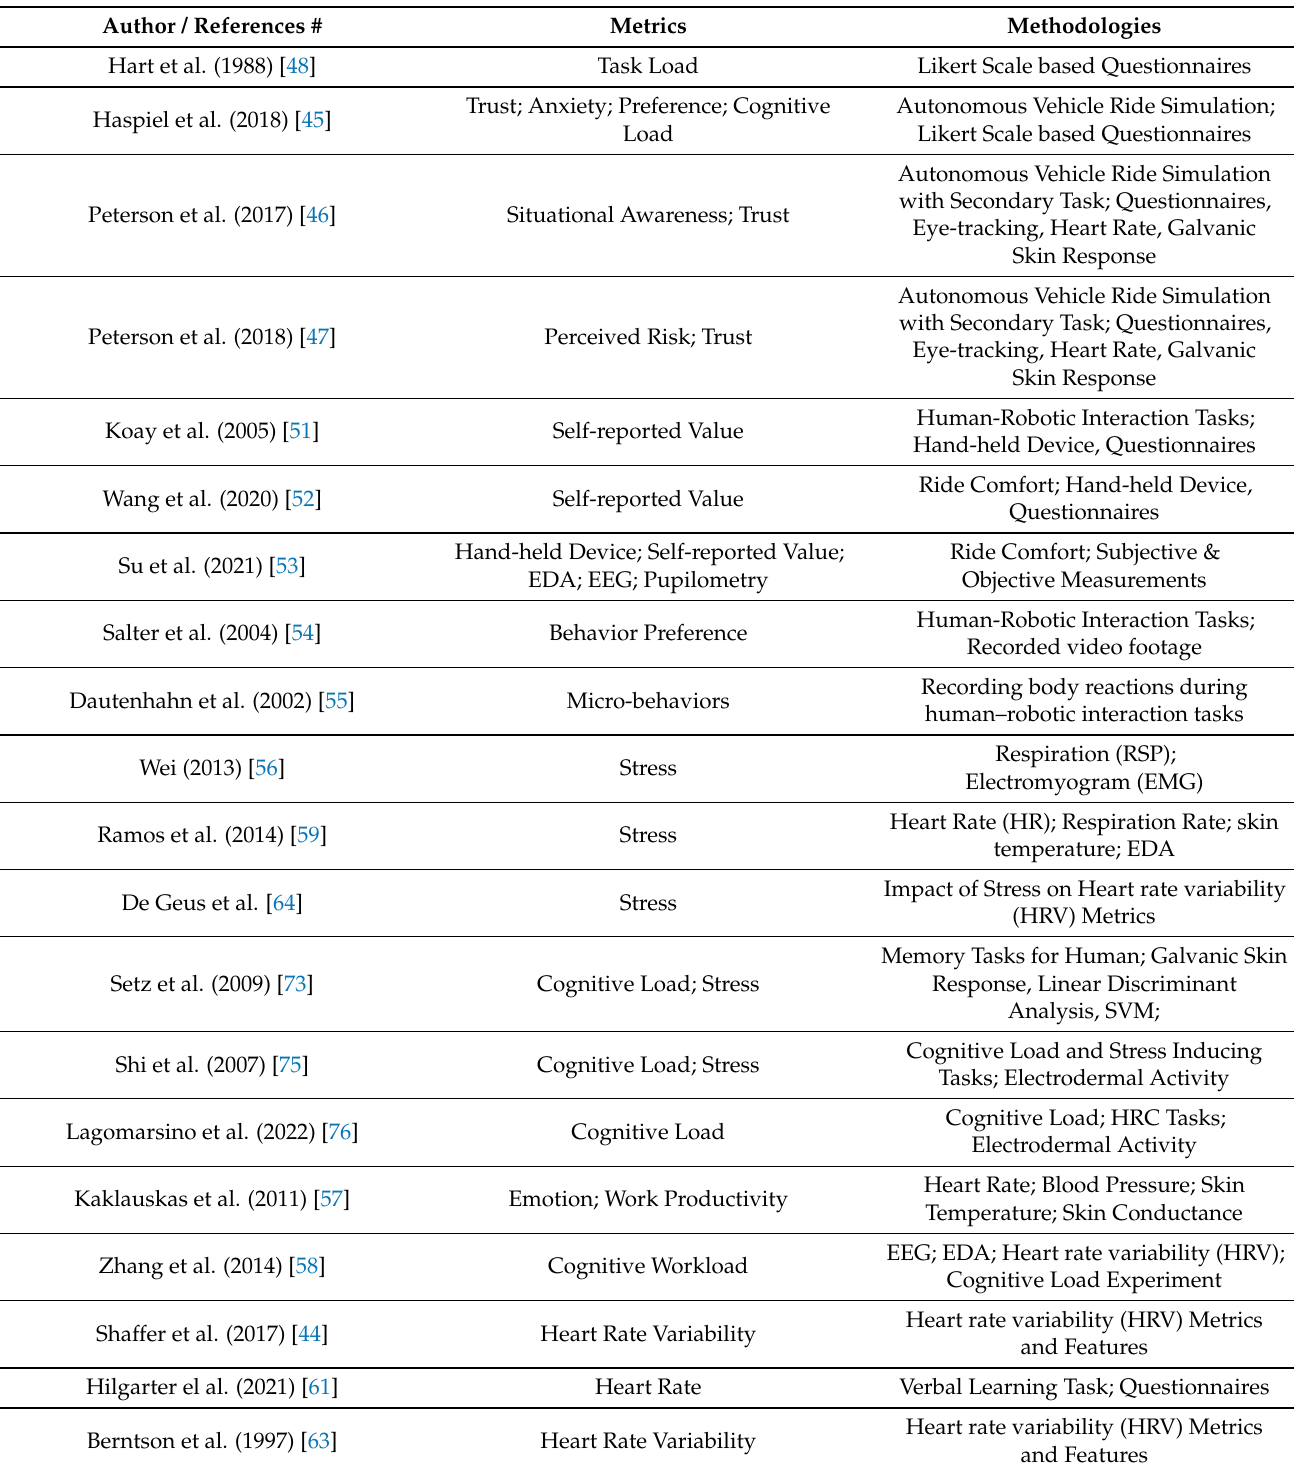
Table 2. Measurement methods and metrics of human